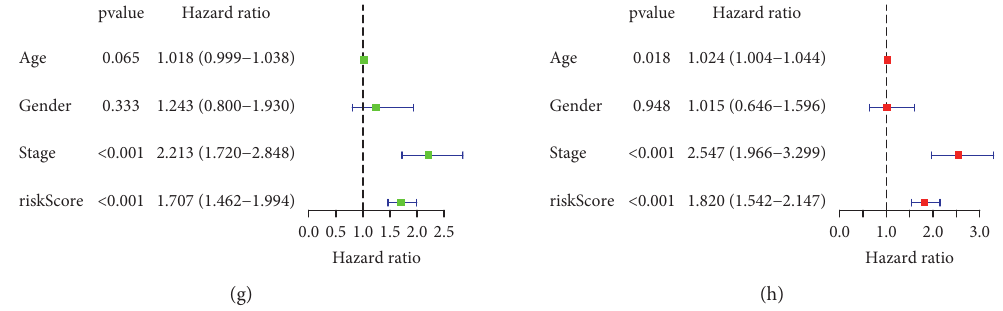
Figure 6: Whether the signature is an independent prognostic factor and relationship between risk score and clinical characteristics is evaluated. (a) Strip chart of clinical characteristics. (b) Age and risk scores; (c) stage and risk scores; (d) T-stage and risk scores; (e) N-stage and risk scores; (f) M-stage and risk scores; (g) univariate and (h) multivariate Cox regression analysis of risk score and clinical char- acteristics. ∗ represented P < 0 . 05, ∗∗ represented P < 0 . 01, and ∗∗∗ represented P < 0 .